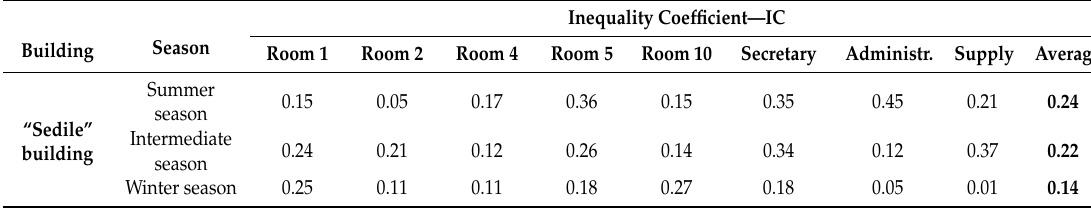
Table 6. Inequality Coefficient for the “Sedile” building.